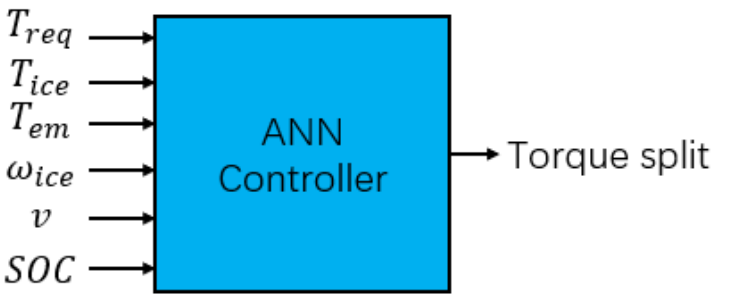
Figure 3. ANN supervisory controller.